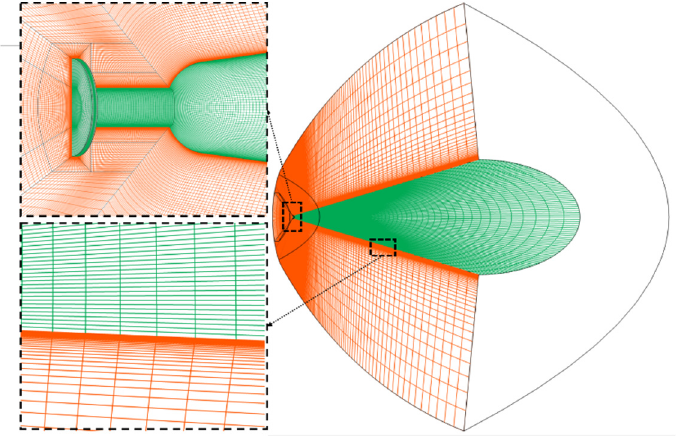
Figure 3. Grids of HIFiRE-5 with the aerodisk. Green: grids on solid surface, Orange: grids on symmetry plane.